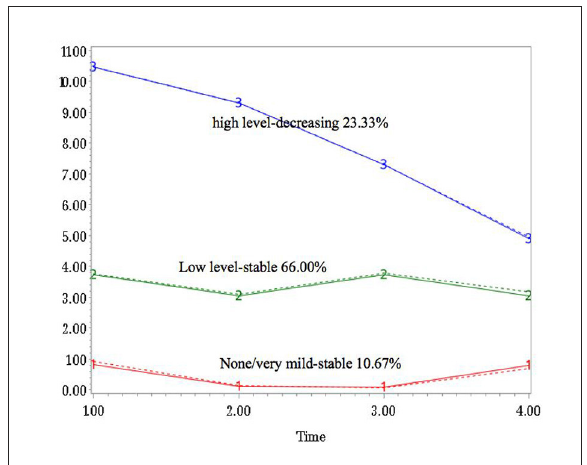
FIGURE2 Group-based trajectories for the depression changes over